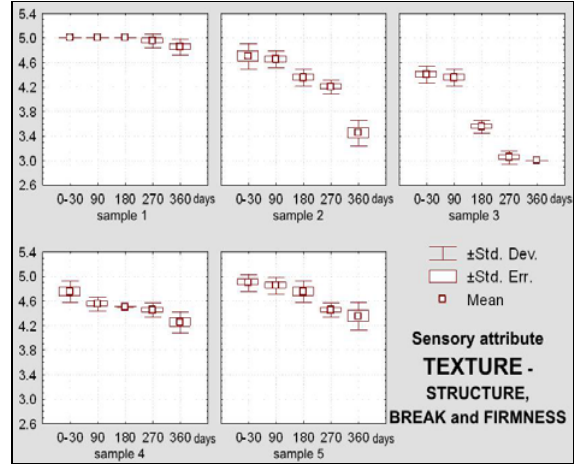
Figure 12 . Box-plots for sensory attribute texture-structure, break and firmness of dietary chocolate.